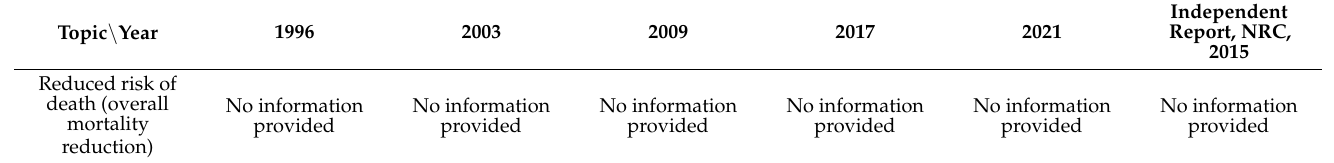
Table 1. Content elements of the Norwegian Mammography Screening Program (NMSP) by year